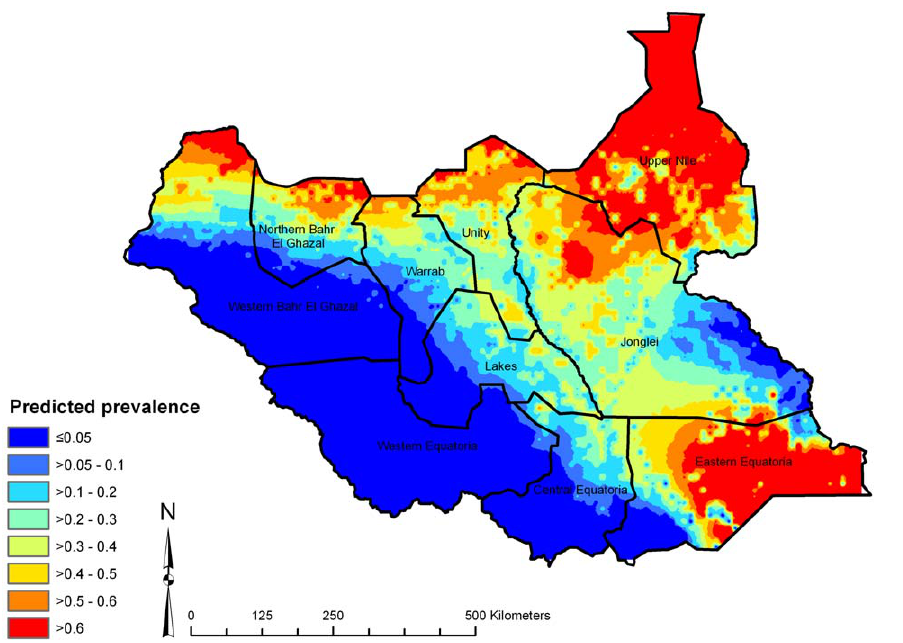
Figure 5. Lower quartile of posterior distribution of predicted prevalence of active trachoma in children aged 1–9 years, Southern Sudan,